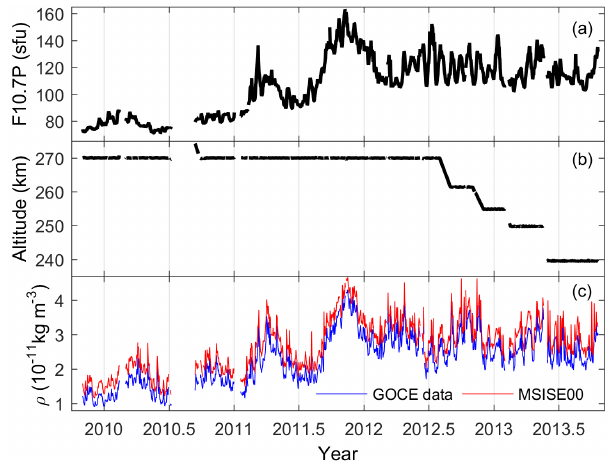
Figure 1. (a) Solar flux index F10.7P, (b) daily mean GOCE height and (c) thermospheric mass density normalized to 270km at dawn and dusk LST during